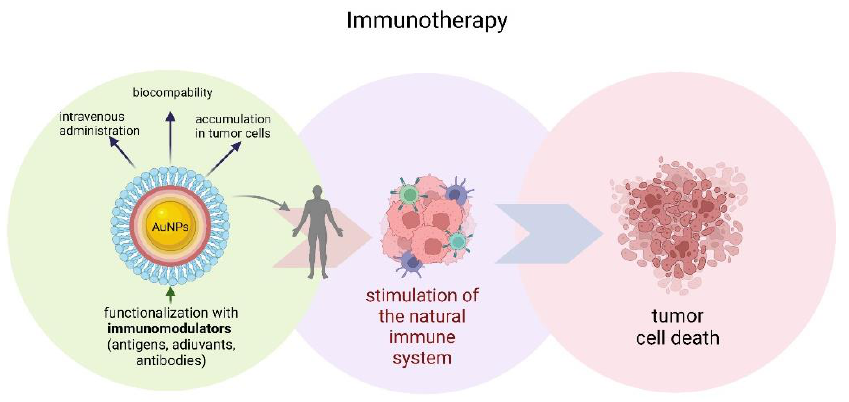
Figure 5 . Schematic illustration of gold nanoparticles immunotherapy